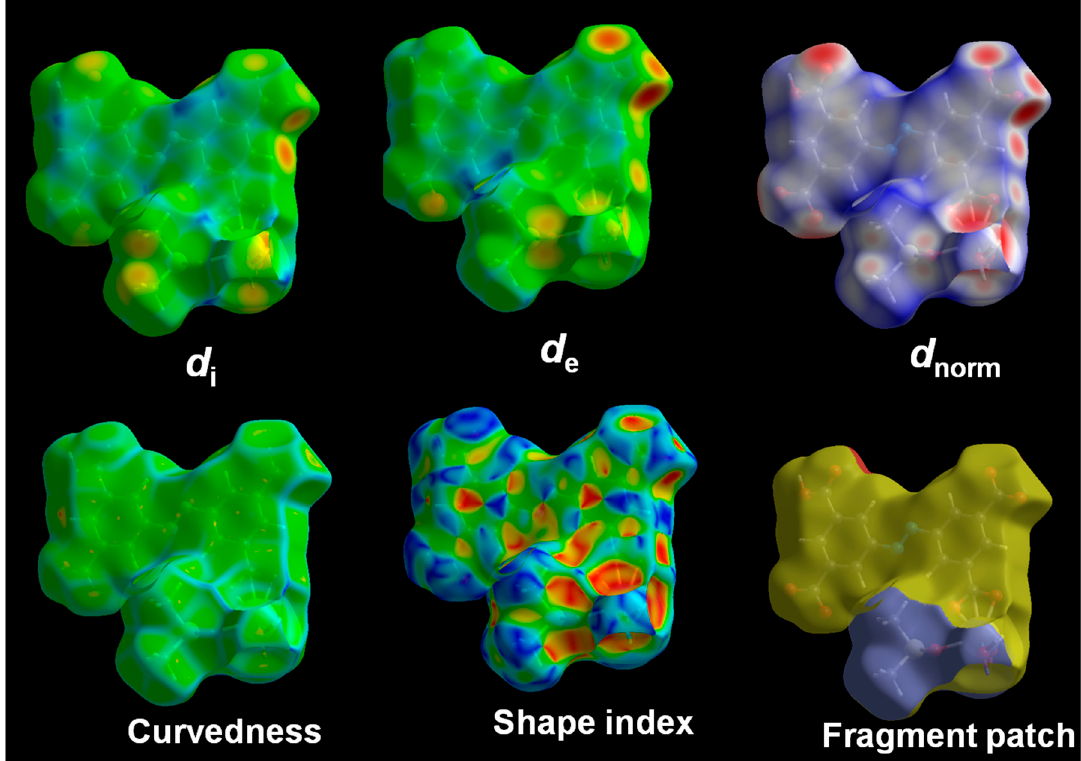
Figure 2. Hirshfeld surface mapped of d i , d e , d norm , curvedness, shape index, and fragment patch in compound ZTU-5 .